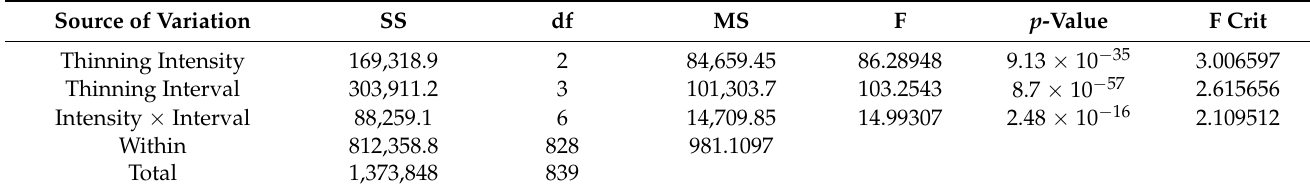
Table A7. Two-way ANOVA test for soil evaporation.